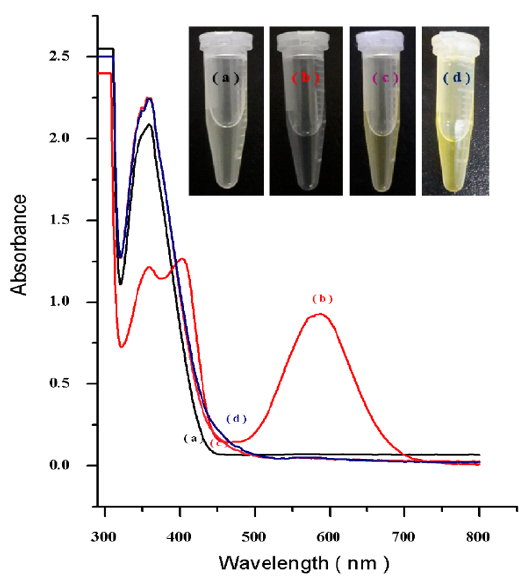
Figure 5. UV-vis ninhydrin absorption spectra of; (a) pure ninhydrin, (b) IBN-1-Cur-2N, (c) IBN-1-Cur-GA, and (d) IBN-1-Cur-CP samples. The photographs of the sample tubes are shown in the inset figure.